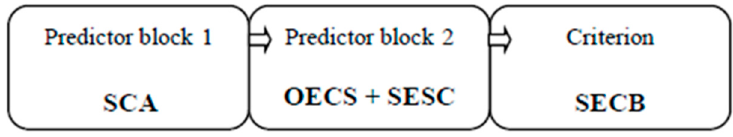
Figure 1. Hierarchical multiple regression model (Hypothesis 3 of study).